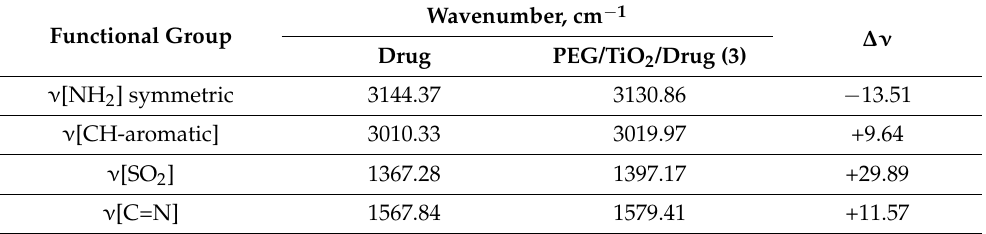
Figure 2. FT-IR spectra of the drug (green), PEG/TiO 2 (black), and PEG/TiO 2 /Drug (red). Table 3. FT-IR difference between pure drug before and after loading upon PEG/TiO 2